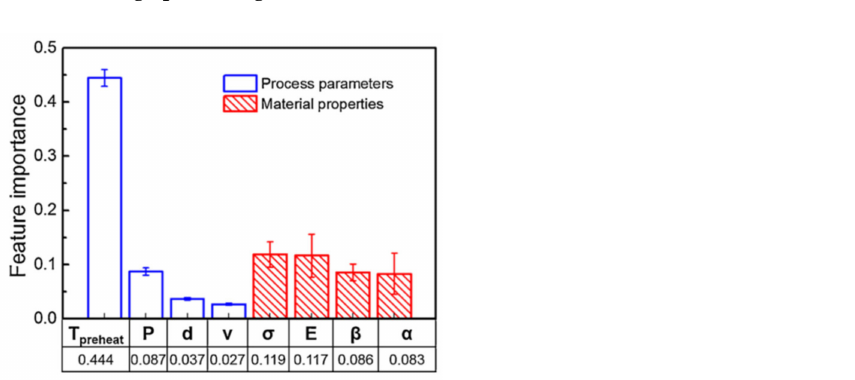
Figure 35. Feature importance of the process parameters. Reprinted with permission from Ref.